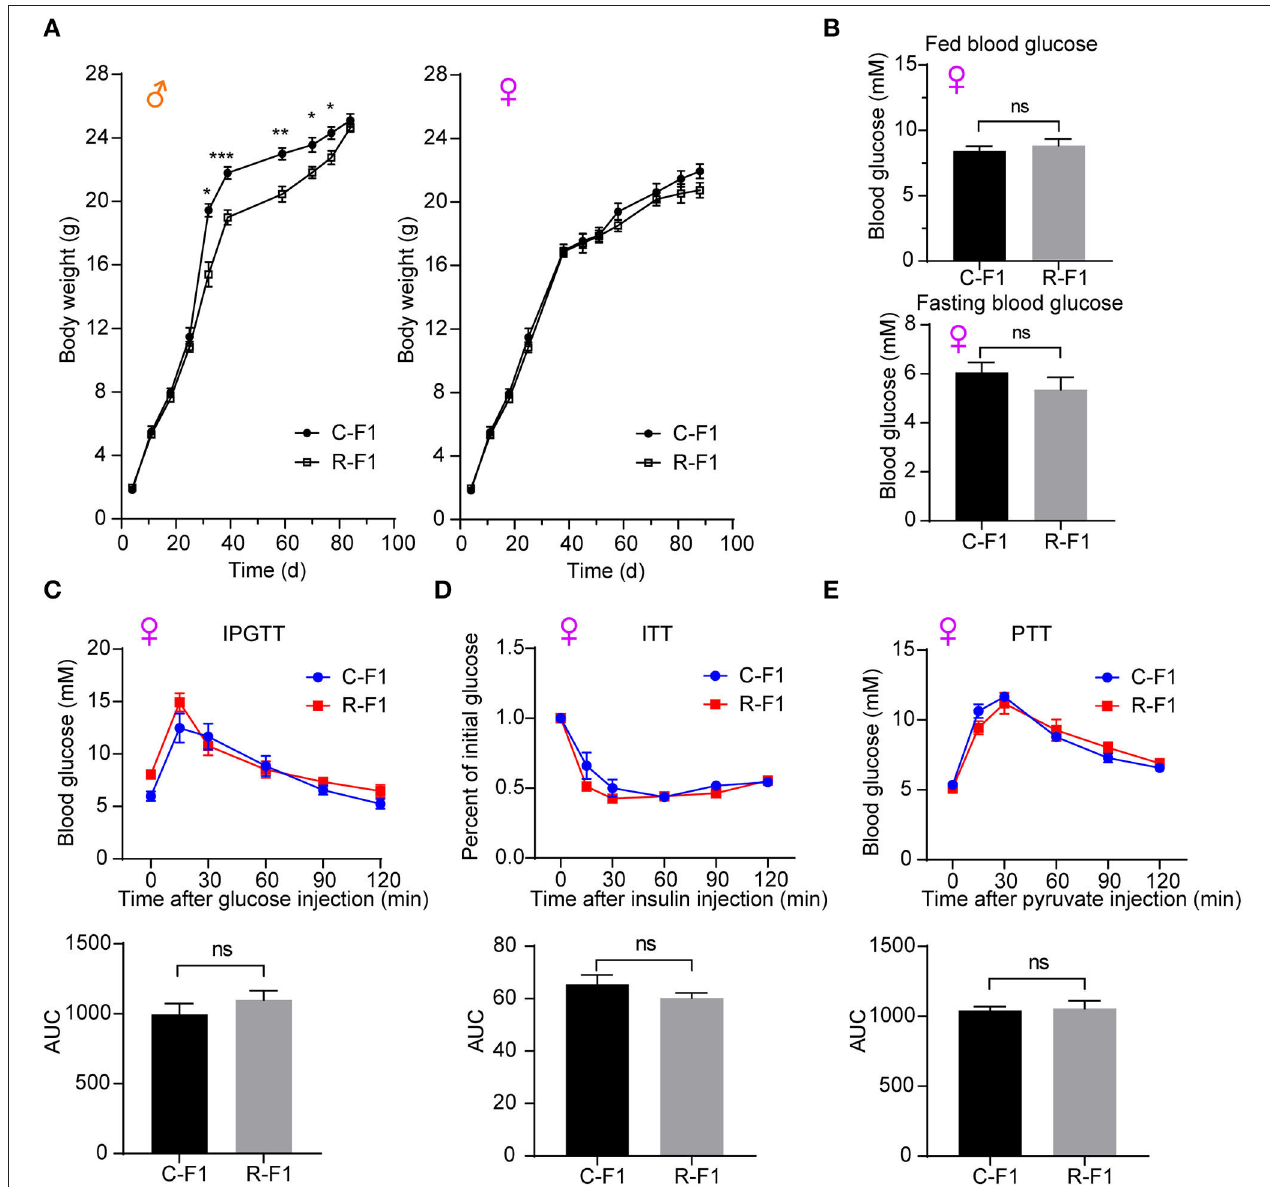
FIGURE 5 | Metabolic phenotypes in female offspring of exposed fathers. (A) The growth curves of F1 mice. (B) The levels of fed blood glucose and fasting glucose in the two female F1 group mice at 7 weeks of age. (C–E) The intraperitoneal glucose tolerance test (IPGTT, 7 weeks of age), insulin tolerance test (ITT, 8 weeks of age), the pyruvate tolerance test (PTT, 9 weeks of age), and the area under the curve (AUC) in the female F1 mice. (A–E) C-F1, F1of the control father; R-F1, F1 of the Radiation father; ns, not significant; * p < 0.05, ** p < 0.01, *** p < 0.001. Student’s t -test. (A) n = 9–10. (B–E) n = 6.